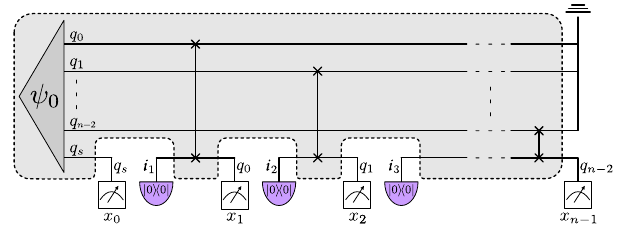
FIG. 2. A process with a temporal probability distribution equivalent to the spatial distribution of the initial state ψ 0 . A mea- surement at time t j constitutes a measurement of an environment qubit (here indexed as q j − 1 ) and results in outcome x j . A new state | 0 (cid:4)(cid:5) 0 | is fed into the subsequent input leg of the process. sampling from the distribution of the output state given by p ( x ) = |(cid:5) x | U | 0 (cid:4) ⊗ n | 2 , where x is a length- n bit